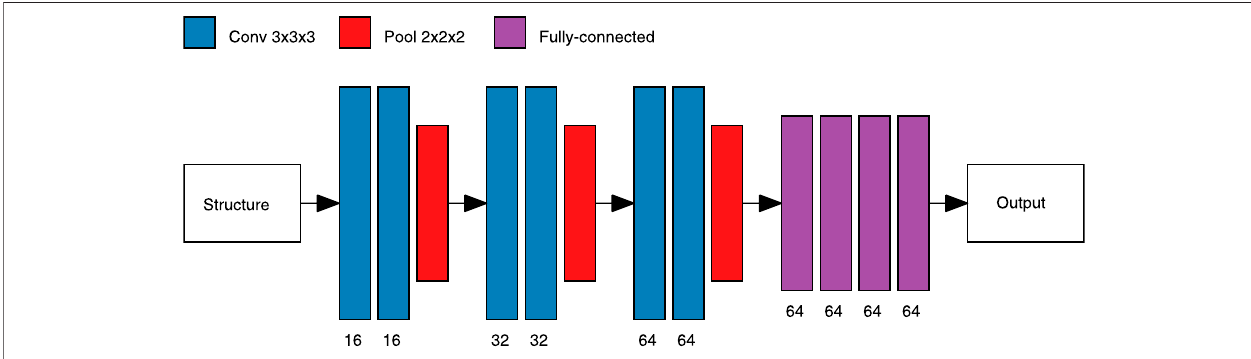
FIGURE 7 | Illustration of the CNN architecture. The inputs, arrays of size 96 3 , are fed into the convolutional part of the network, consisting of three convolutional blocks, each in turn consisting of two convolutional layers (the numbers of fi lters are indicated in the fi gure) followed by an average pooling layer. The feature maps produced as output from the convolutional part are passed to 4 fully-connected layers with 64 nodes each.